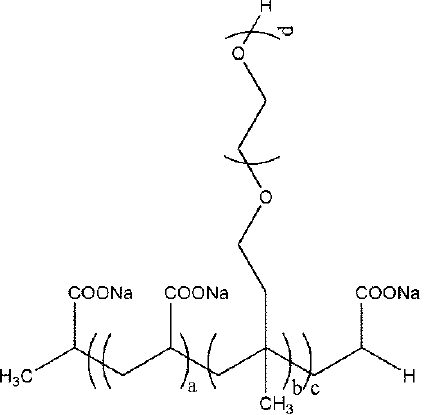
Figure 1. The chemical structure of polycarboxylate ether PCE.